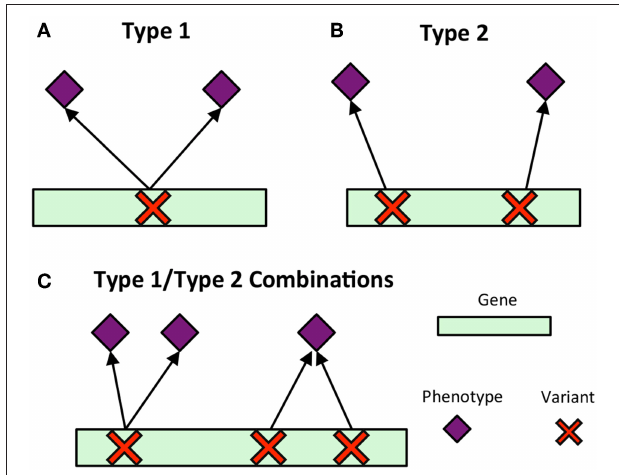
FIGURE 1 | MPA signatures. (A) Type 1 MPA: a gene is associated with more than one phenotype due to a single variant within the gene associating with multiple phenotypes. (B) Type 2 MPA: a gene is associated with more than one phenotype because of alternate SNPs within the gene having different phenotypic associations (figure created from information presented in Solovieff et al., 2013 ). (C) Complex combinations of Type 1 and Type 2 signatures.